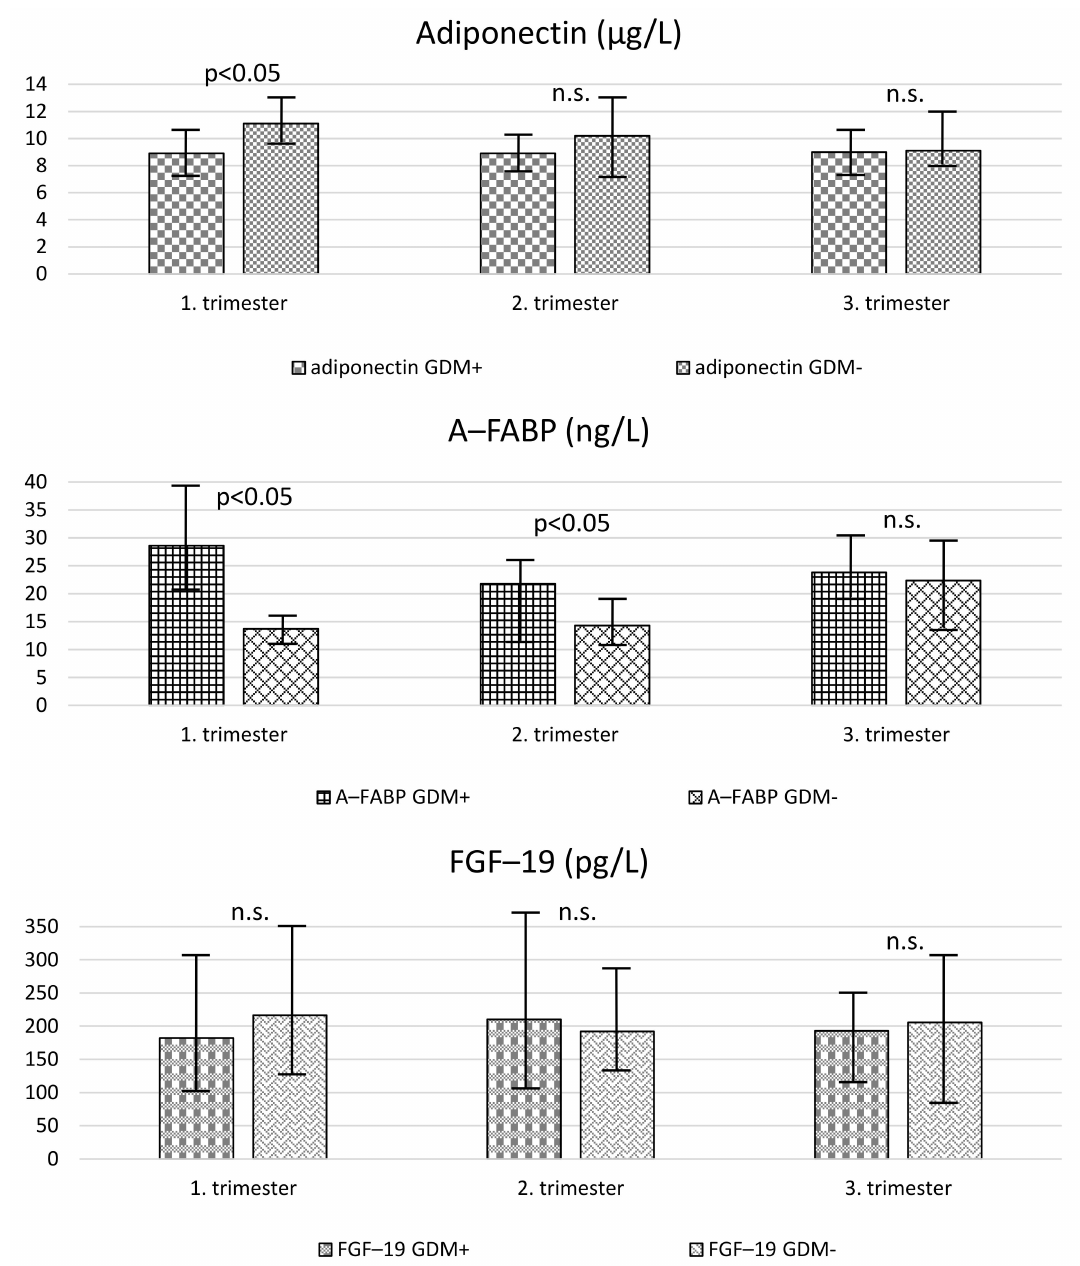
Figure 1. Levels of adipokines in different groups. GDM = gestational diabetes mellitus; A-FABP = adipocyte fatty acid-binding protein; FGF-19 = fibroblast growth factor-19. Values are expressed as medians (boxes) and interquartile ranges